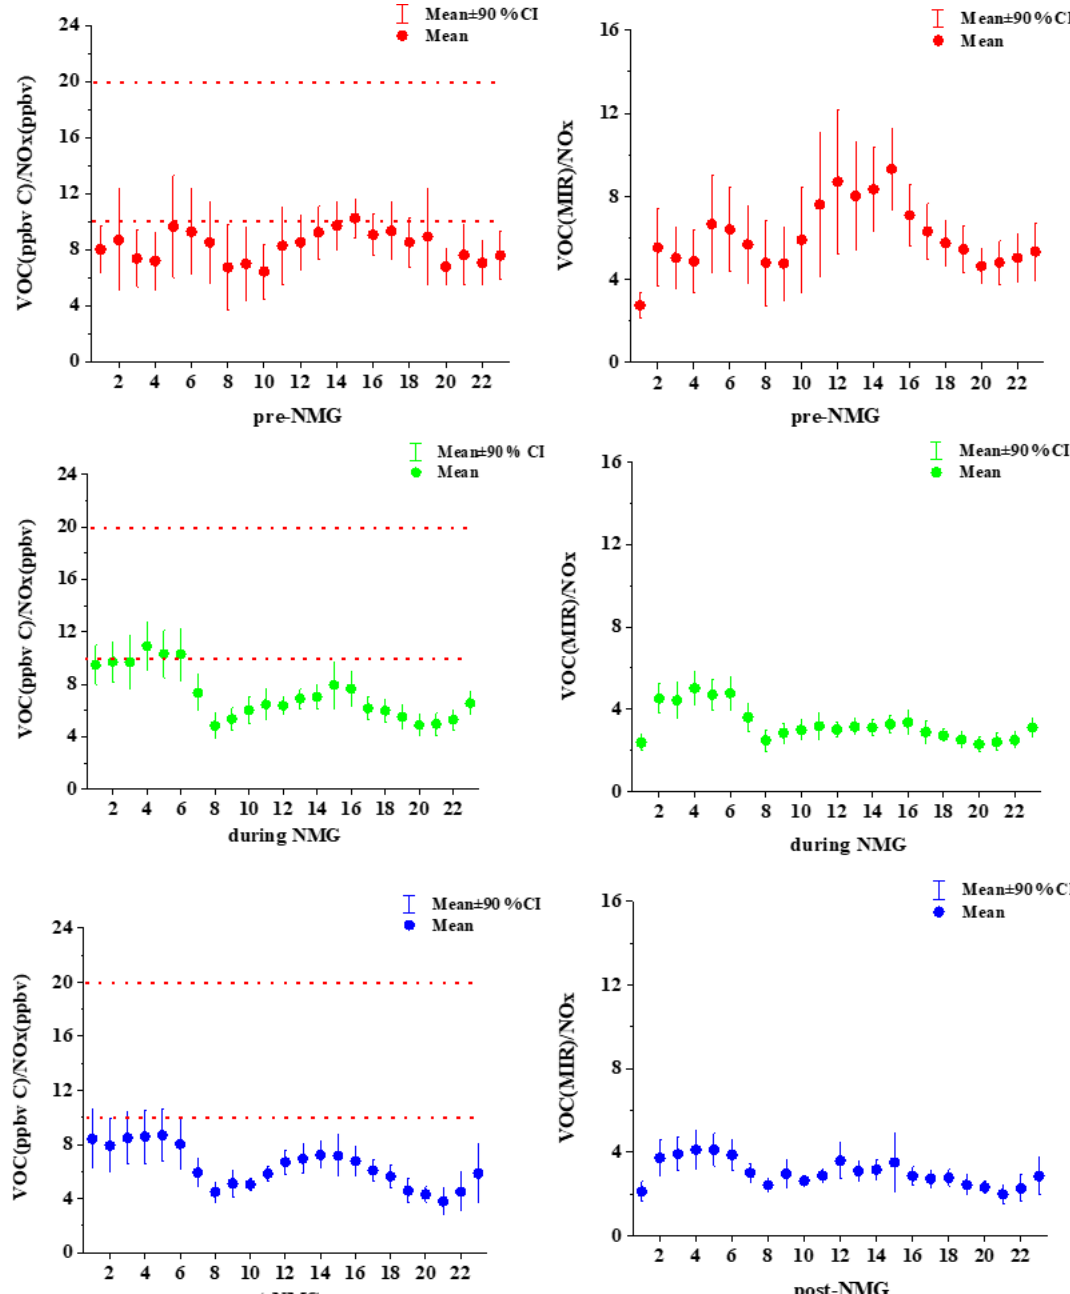
Figure 8. Daily variations in the VOC / NO x ratio in Zhengzhou before, during, and after the NMG period.